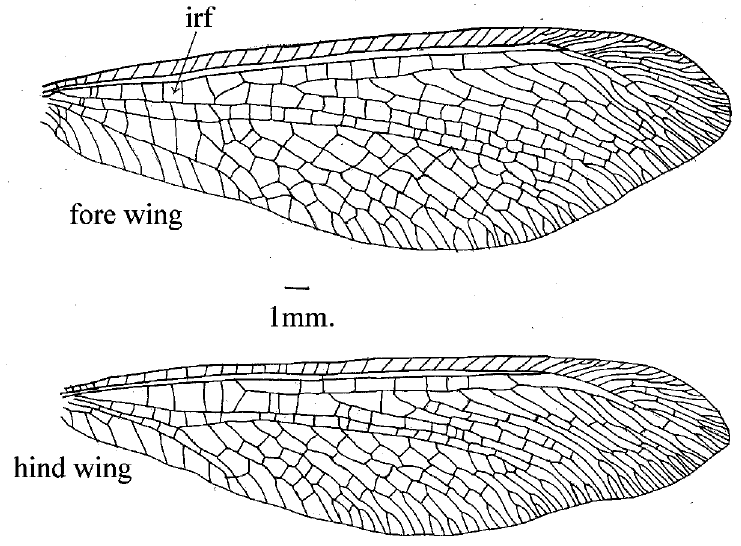
F IG .4. - Fore and hind wing. irf; inner radal field. Abdominal segments: yellow, composed of 9 segments. A mid dorsal longitudinal brown line extends from the first to the last abdominal segment .On each side of the 6 th and 7 th abdominal segments is attached a pleuritosquamae (Fig .5.), with long hairs especially dense on its distal part. Genitalia of male imago, consists of gonarcus and paramer (figs.6 and 7. successively, lateral and ventral